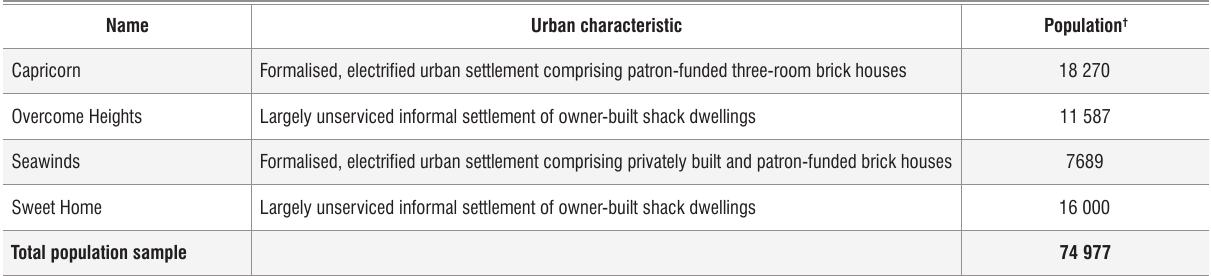
Urban localities in Cape Town sampled for wild harvested natural resource based businesses and traditional healers Name